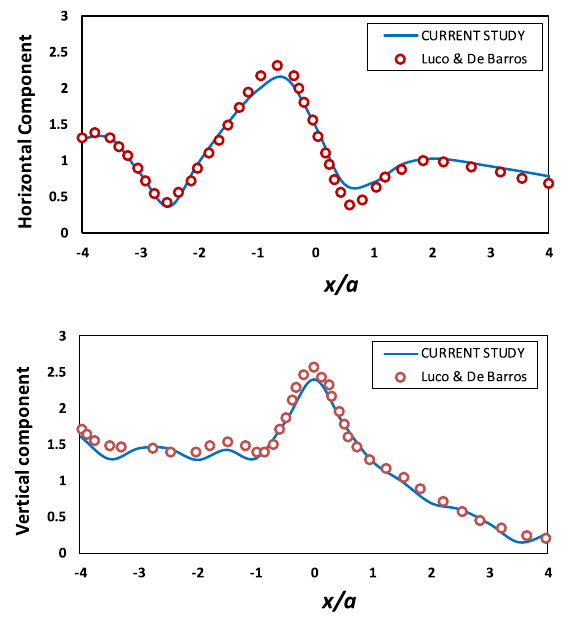
Fig. 5 Verification of horizontal and vertical displacement compo- nent of the present study with the results of Luco and De Barros (η = 0.5, d/a = 1.5)